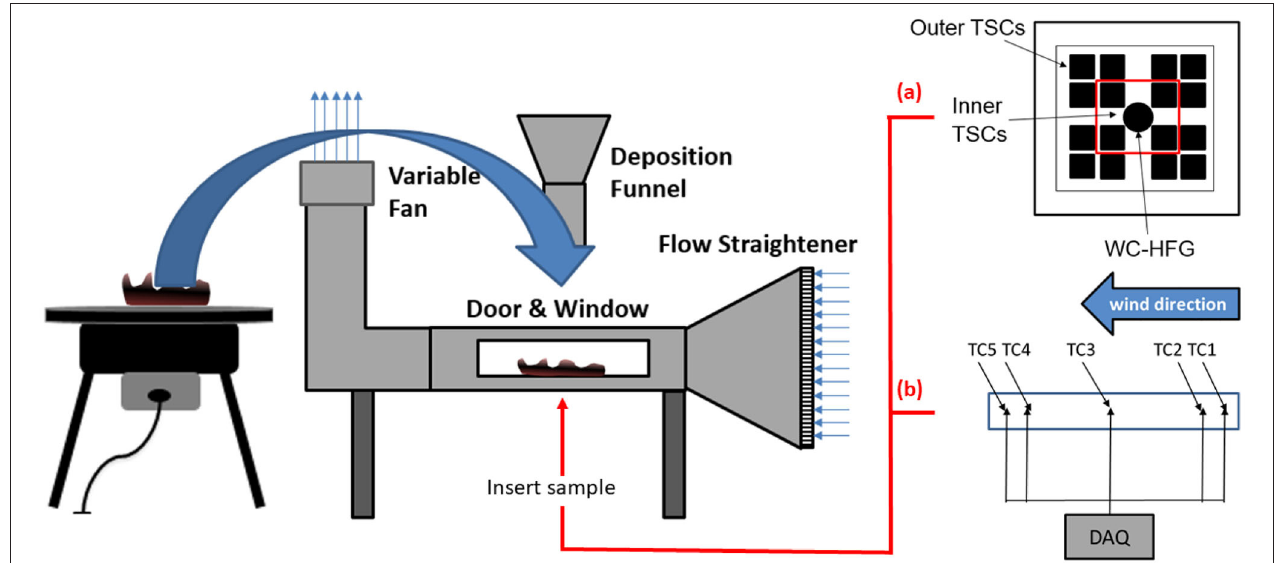
FIGURE 1 | Schematic of the experimental setup, from left to right: burner used to ignite firebrands (modified figure from Caton, 2016), enclosed wind tunnel, (a) sensor array for inert tests with thin-skin calorimeters (TSC) and a water-cooled heat flux gauge (WC-HFG), and (b) thermocouple (TC) array for ignition tests, and data acquisition (DAQ) system.